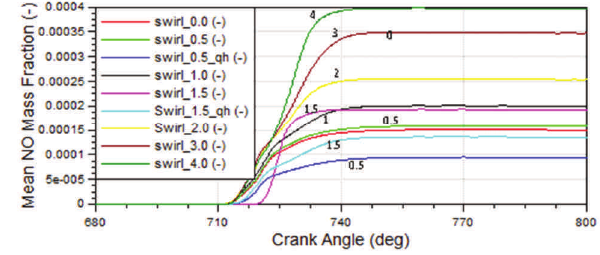
Fig. 9. Mean NO mass fraction at different crank angle positions and different swirl ratios